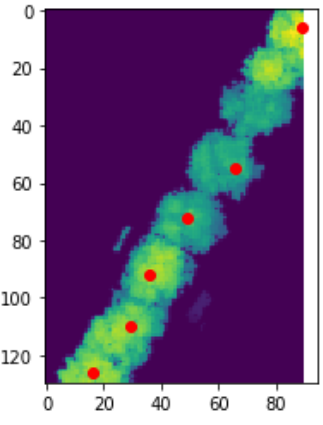
Figure 9. Trucks classified as tree